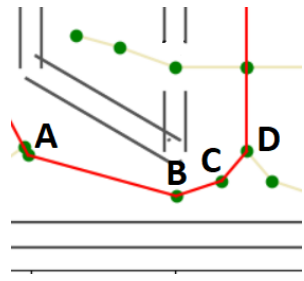
Figure 8. Sequence of very close distances